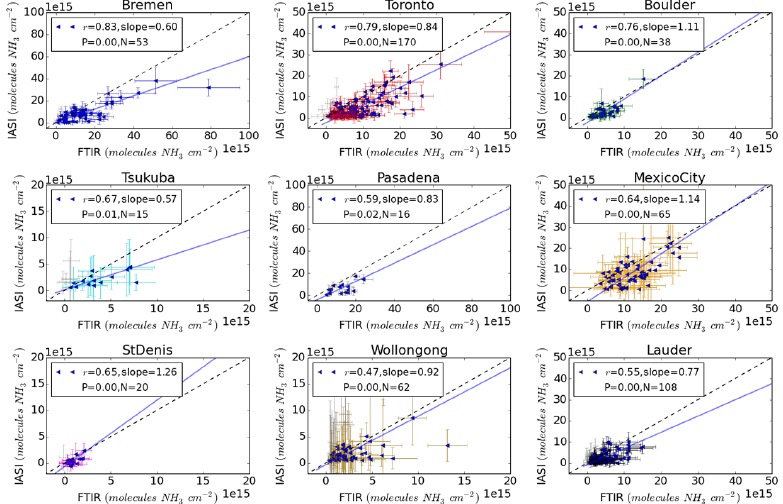
Figure 6. Correlations between the FTIR and IASI total columns with filters thermal contrast > 12, t diff < 90min, x diff < 25km. The trend lines show the results of the regression